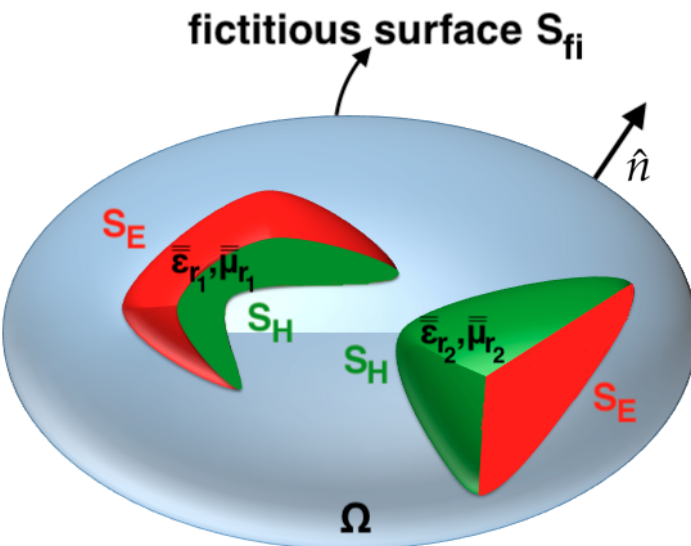
Figure 1. Arbitrarily shaped 3 D unbounded domain Ω loaded with different inhomogeneous materials, containing perturbations of PEC ( S E ) and PMC ( S H ) denoted by distinct colors. The unbounded solution domain Ω is truncated by a fictitious closed surface S fi